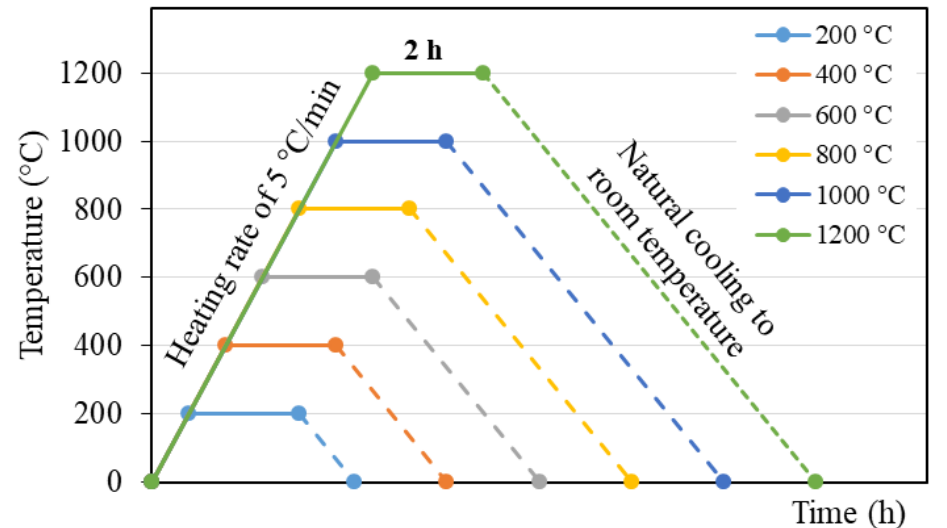
Figure 2. Heat treatment process of the BGF samples.